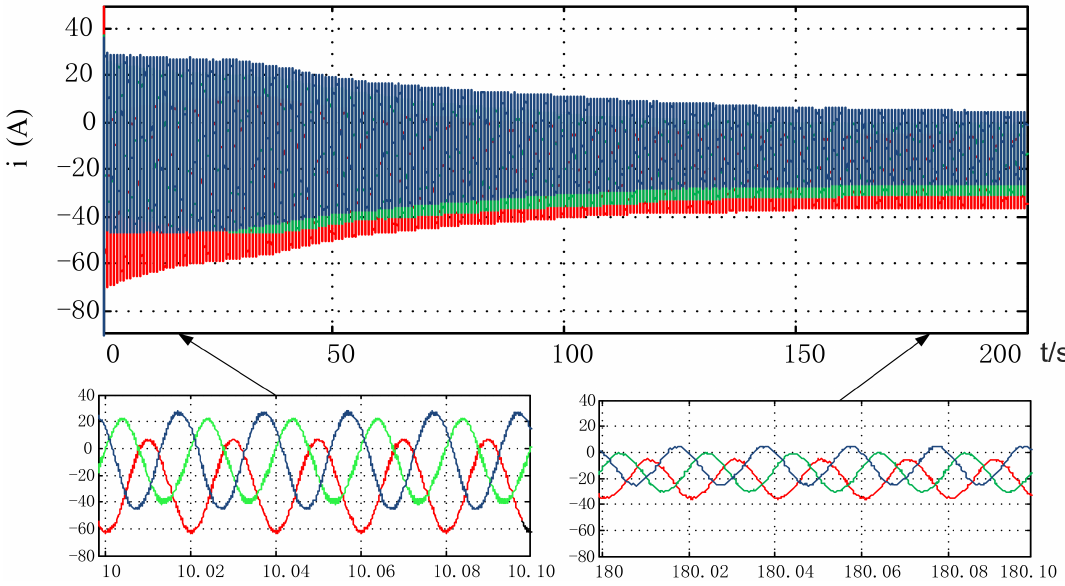
Figure 10. The circulating currents of the three-phase